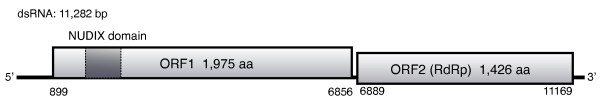
Diagrammatic representation of genome organization of LeV. The dsRNA of LeV encodes two ORFs. ORF1 is an unknown protein and has a region with high similarity with the NUDIX domain. ORF2 encodes the RNA-dependent RNA polymerase (RdRp).